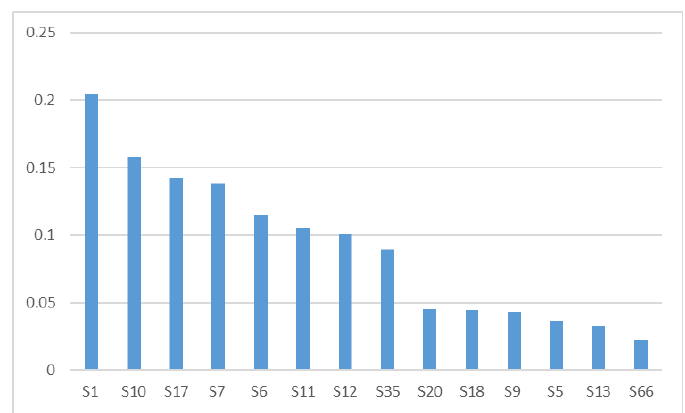
Figure 3. Percentage of app users by Sheffield postcodes.